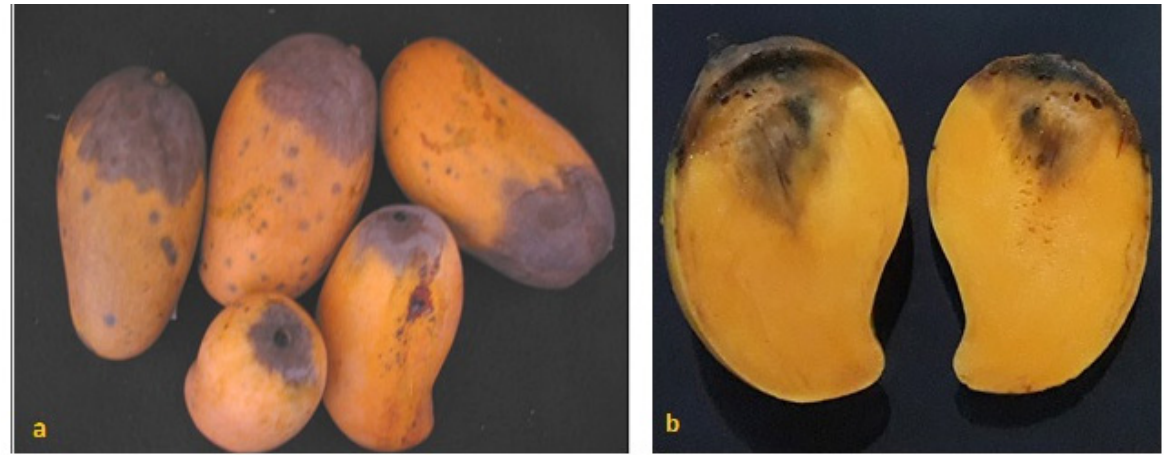
Figure 1: (a) External symptoms of SER on ripe mango fruit, and (b). A vertically halved mango fruit showing internal pulp symptoms due to